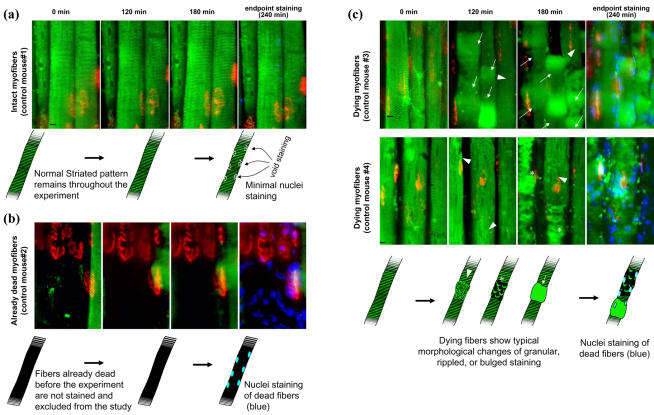

 In vivo microscopic assay of myofiber damage.Identical positions of the myofibers were traced by examining the anatomy of the individual myofibers (stained green), and/or the shape and relative location of NMJs (stained red by BTX-Alexa Fluor 594). (a) Intact cells in control mice with no treatment showed a normal striated pattern of staining of M/ER with DiOC6 (Intact myofibers, control mouse#1). (b) Already dead myofibers (killed by electrical ablasion 1 hour before the experiment) are not stained and excluded from the study. (c) When cells are induced to death by combination of severe ischemia (L-NAME, apamin, charybdotoxin, and vascular oppression) and strenuous contraction (12 times repeat of tetanic stimuli), distribution of these DiOC6-stained compartments becomes granular (arrow heads) or bulged (arrows), or exhibit a rippled pattern (asterisk). Each image is in focus. Cell death identified by abnormal DiOC6 labeling was confirmed by dye-exclusion staining with short exposure to Hoechst33258 (blue color at endpoint in each group). The black scale bar in the figure represents 10 µm.